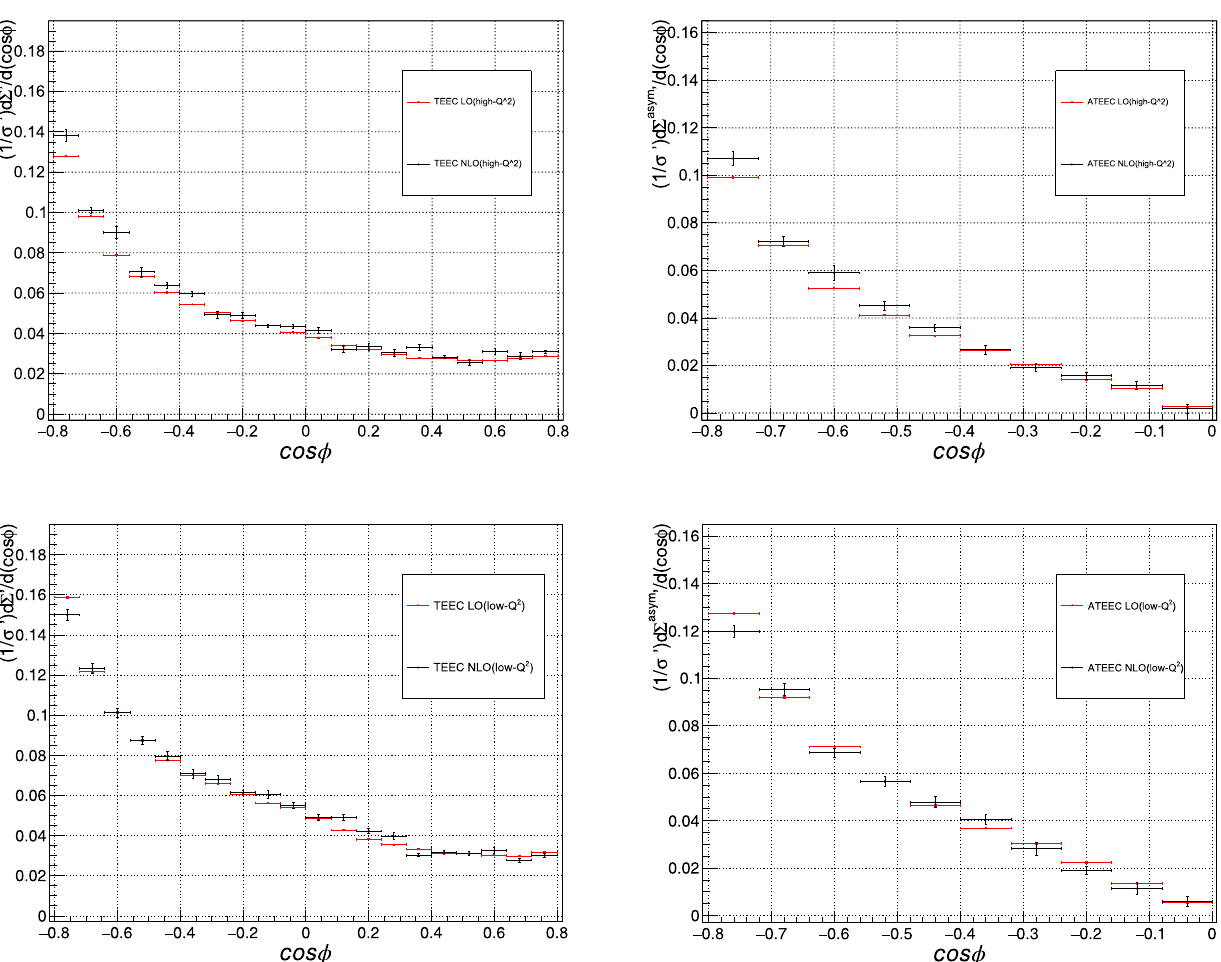
(cid:2) (cid:4) E (cid:5) 2 + Q 2 and T